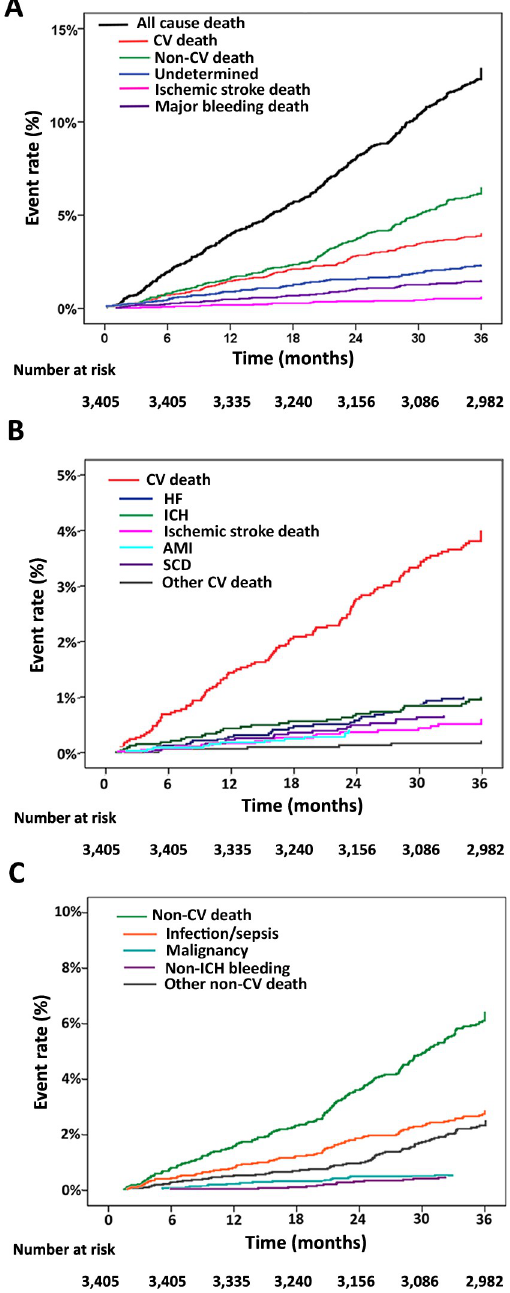
Fig 2. Cumulative event rate of (A) all death, CV death, non-CV death, undetermined death, ischemic stroke death, and major bleeding death; (B) the components of CV death; and, (C) the components of non-CV death. ( Abbreviations: AMI, acute myocardial infarction; CV, cardiovascular; HF, heart failure; ICH, intracranial hemorrhage; SCD, sudden cardiac